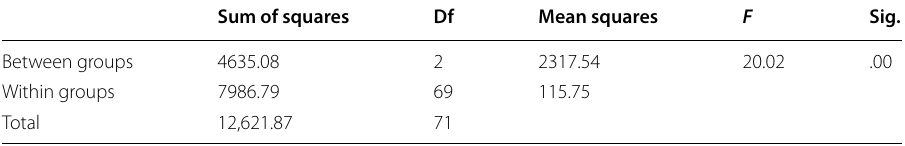
Table 5 Multiple comparisons by Bonferroni test (test anxiety)